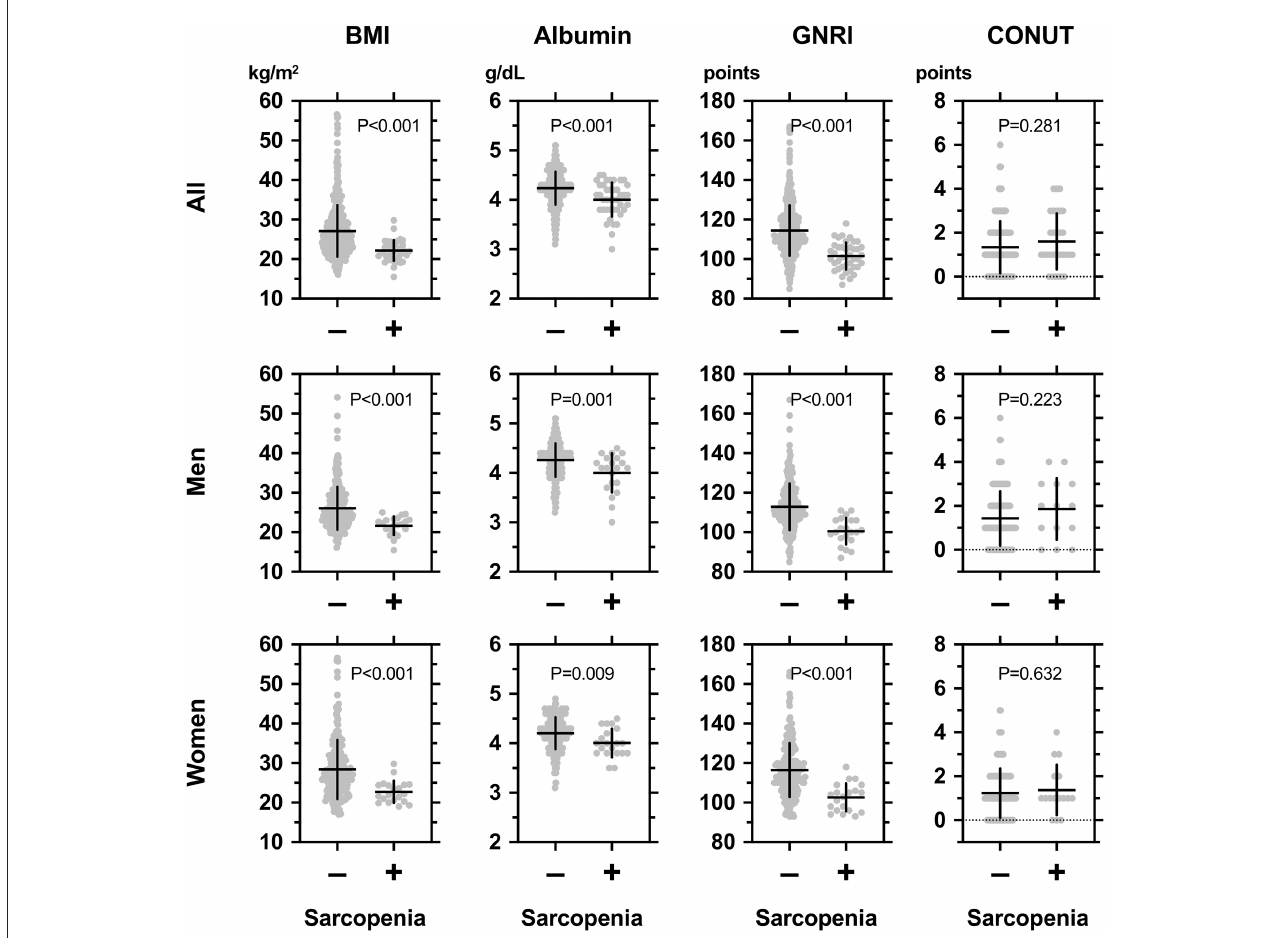
FIGURE1 Comparisons among body mass index (BMI), serum albumin concentrations, geriatric nutritional risk index (GNRI), and controlling nutritional status (CONUT) between individuals with ( + ) or without (–) sarcopenia in all participants (upper panel) , men (middle panel) , and women (lower panel) with type 2 diabetes mellitus. The definition and diagnosis of sarcopenia were based on the Asian Working Group for Sarcopenia (AWGS): 2019 Consensus Update on Sarcopenia Diagnosis and Treatment (2). In brief, “low muscle power” was defined as handgrip strength < 28kg for men and < 18kg for women; the criterion for “low physical performance” was walking speed < 1.0 m/s as evaluated by the time required for walking 10m; and “low appendicular skeletal muscle mass (ASM)” was defined as a skeletal mass index (BMI) < 7.0 kg/m 2 in men and < 5.7 kg/m 2 in women. Sarcopenia was defined by low skeletal mass index (SMI) and low muscle power or low physical